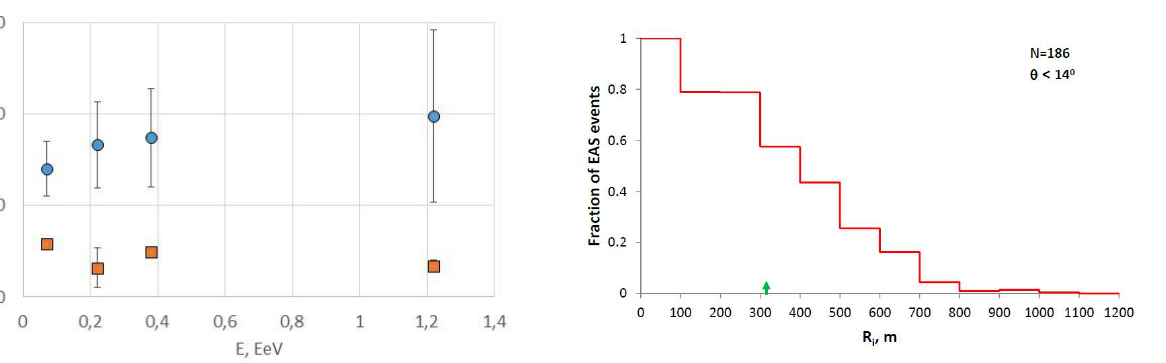
erably increased at the lower threshold energy of the